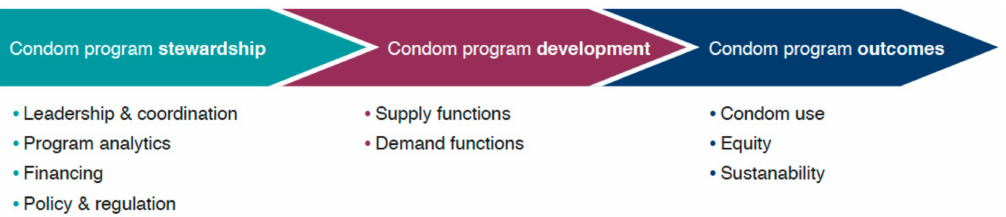
Figure 1. The Condom Program Pathway, a theory of